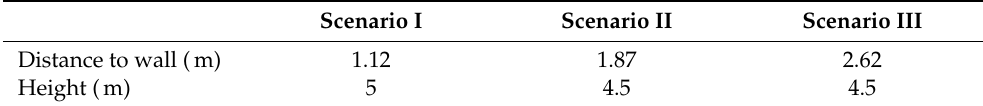
Table 4. Wall-following trajectory parameters for the three different